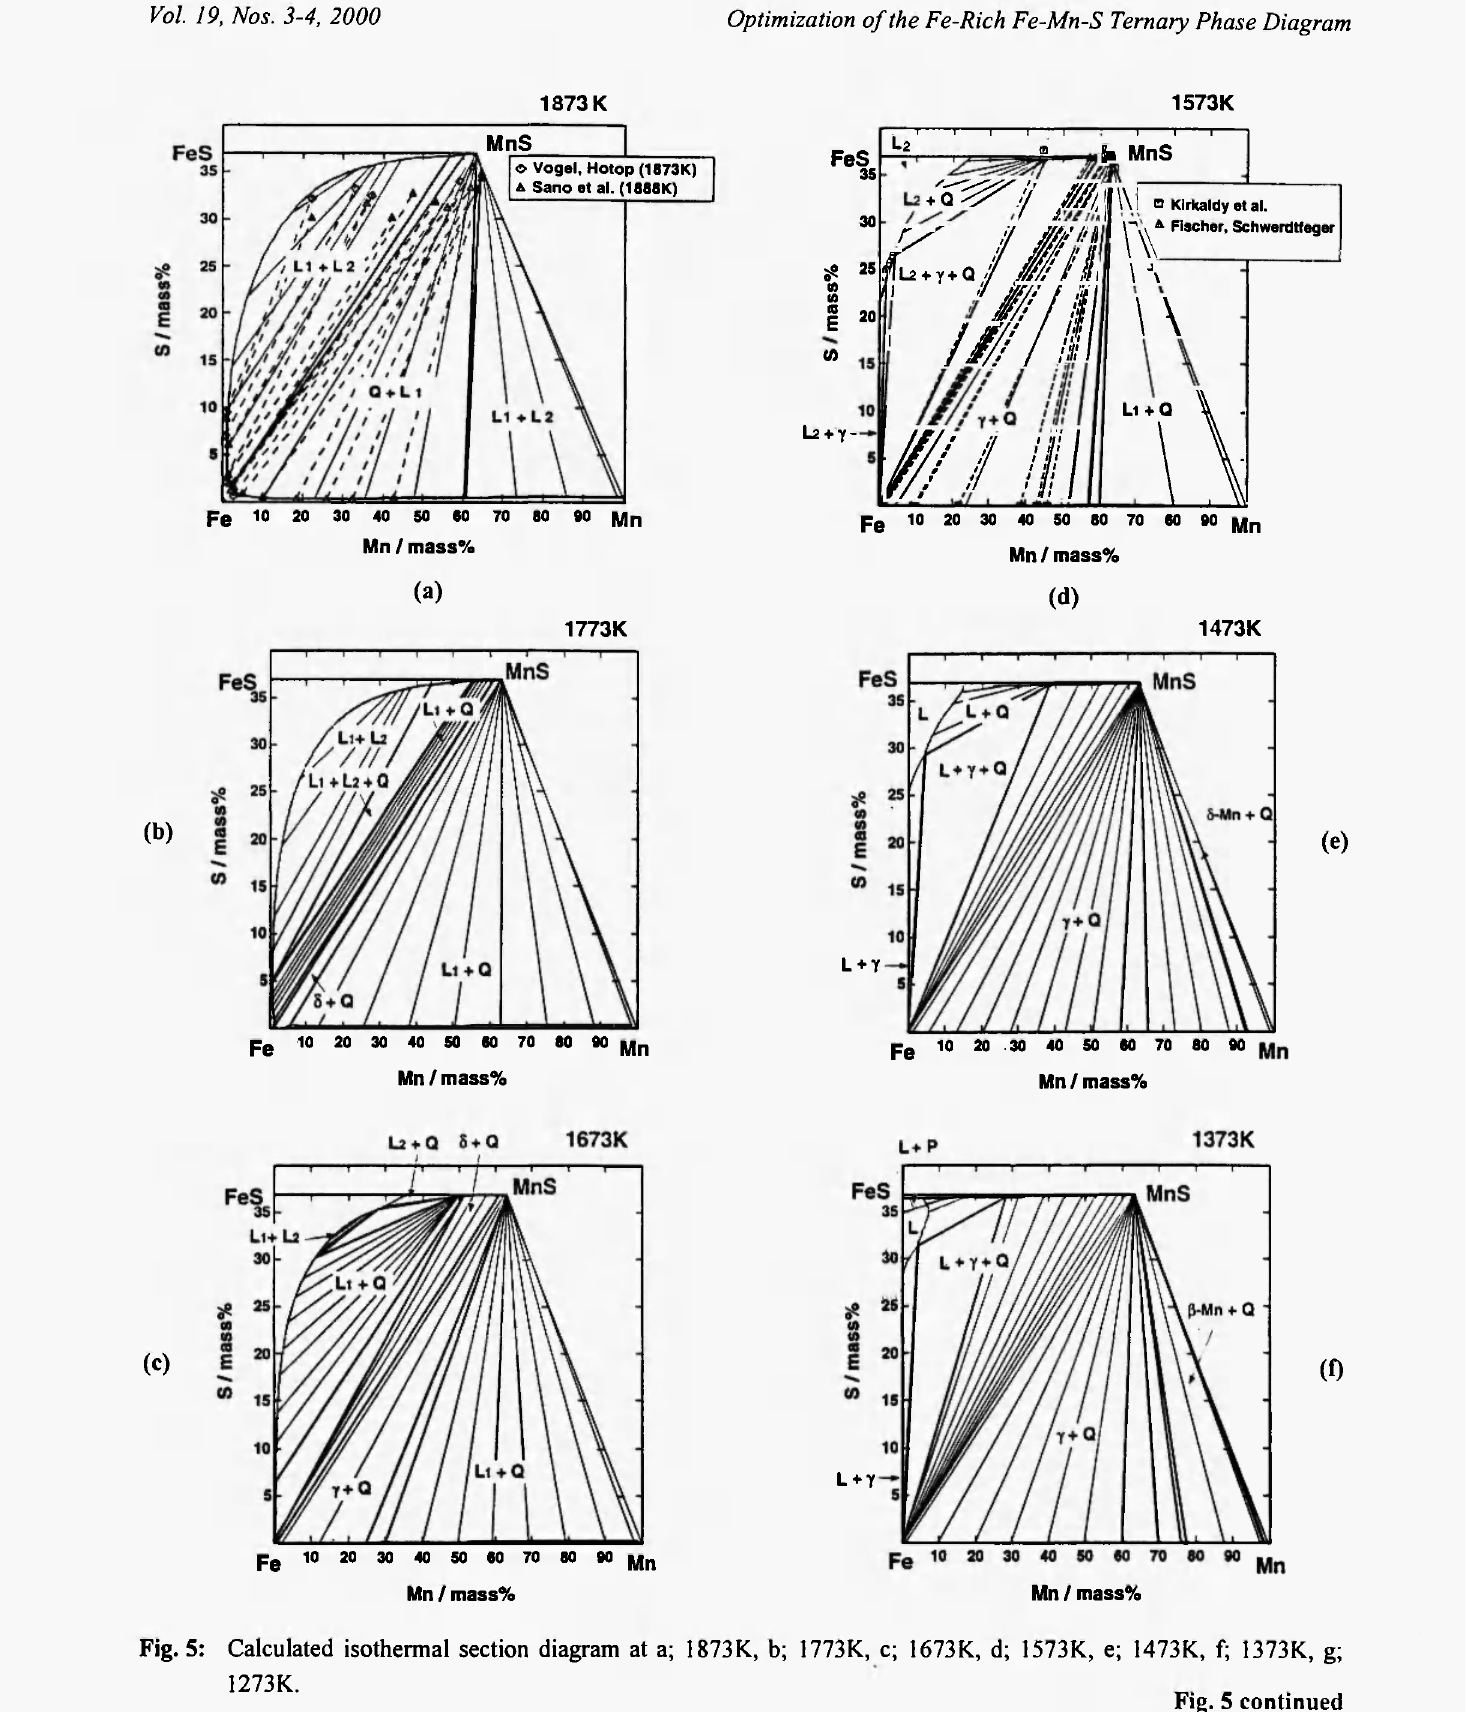
Fig. 5: Calculated isothermal section diagram at a; 1873K, b;